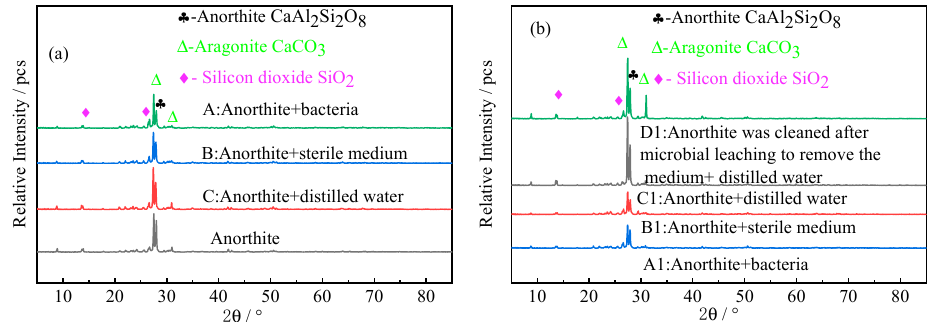
Figure 5. XRD patterns of anorthite leaching residue ( a ) and carbonation products ( b ).